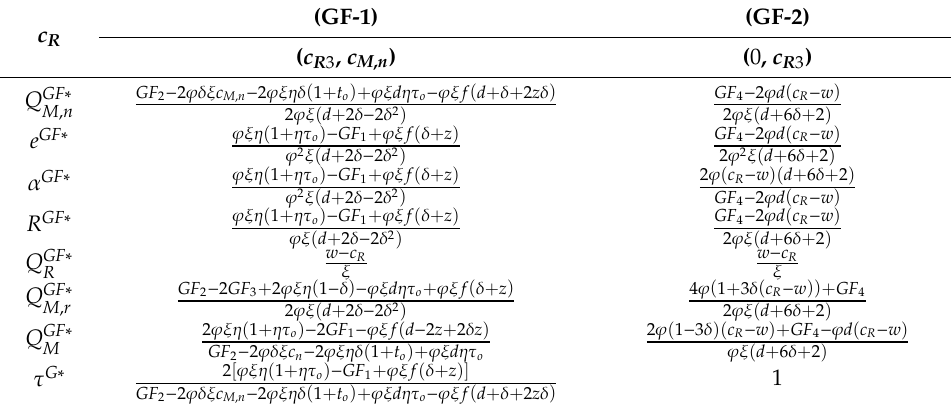
Table 7. The optimal solutions for the GF